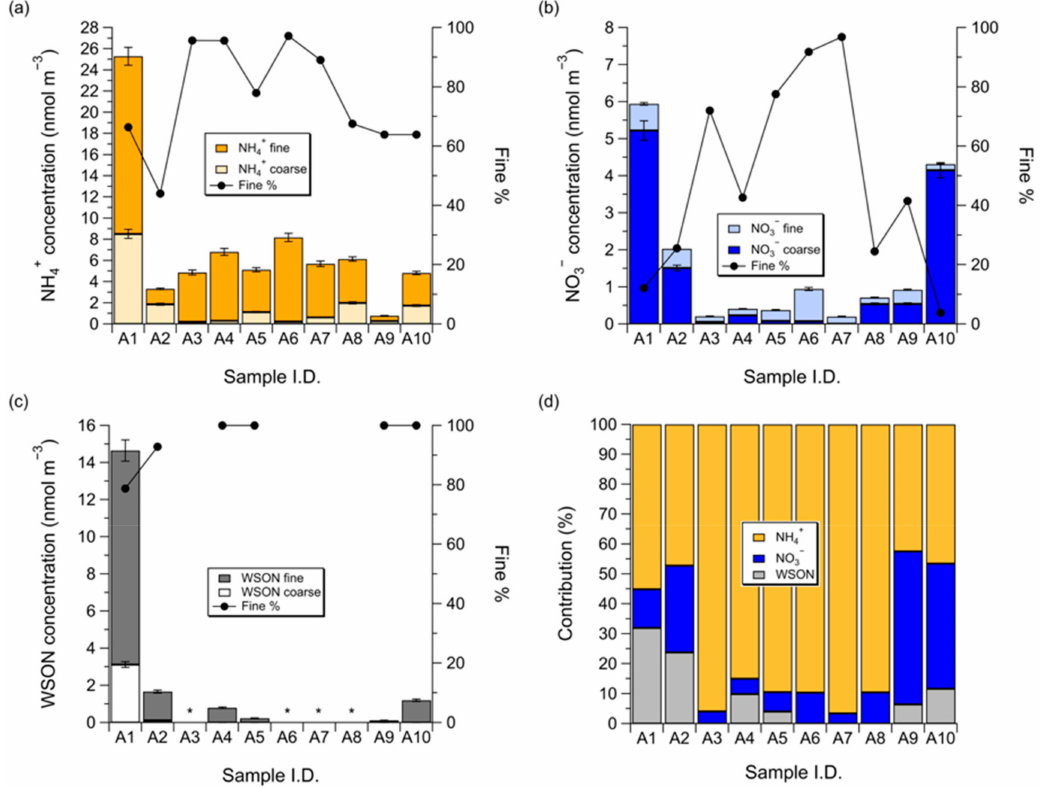
Figure 2. Concentrations of ( a ) NH 4 + , ( b ) NO 3 − , ( c ) water-soluble organic (WSON) in aerosols collected over the subarctic western North Pacific Ocean, and ( d ) the contribution of each N species against sample I.D. Solid circle lines in ( a – c ) show the percentage of NH 4 + , NO 3 − , and WSON in fine (D < 2.5 µ m) aerosol particles. Stars in ( c ) indicate that WSON was not